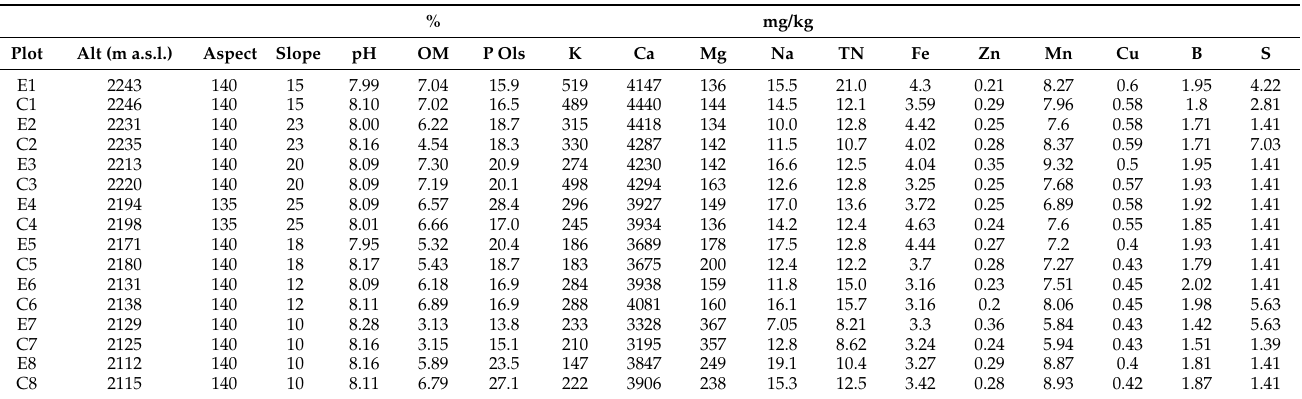
Table 1. Plot characteristics and nutrient content of the plots (“E” for exclusion plots and “C” for control plots). Aspect measured in degrees and slope in sexagesimal degrees. Nutrient content is measure in percentage (%) or mg/kg.